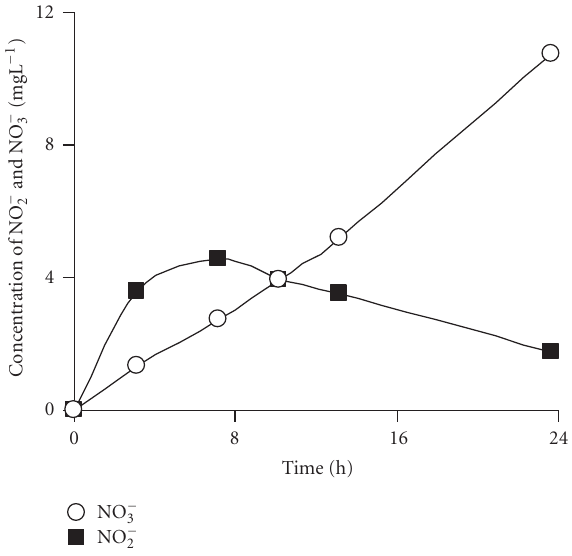
Figure 2: Formation of NO − 3 ( (cid:2) ), NO − 2 ( (cid:2) ) in PCO of MA at pH 11 and initial concentration of MA 100 mgL − 1